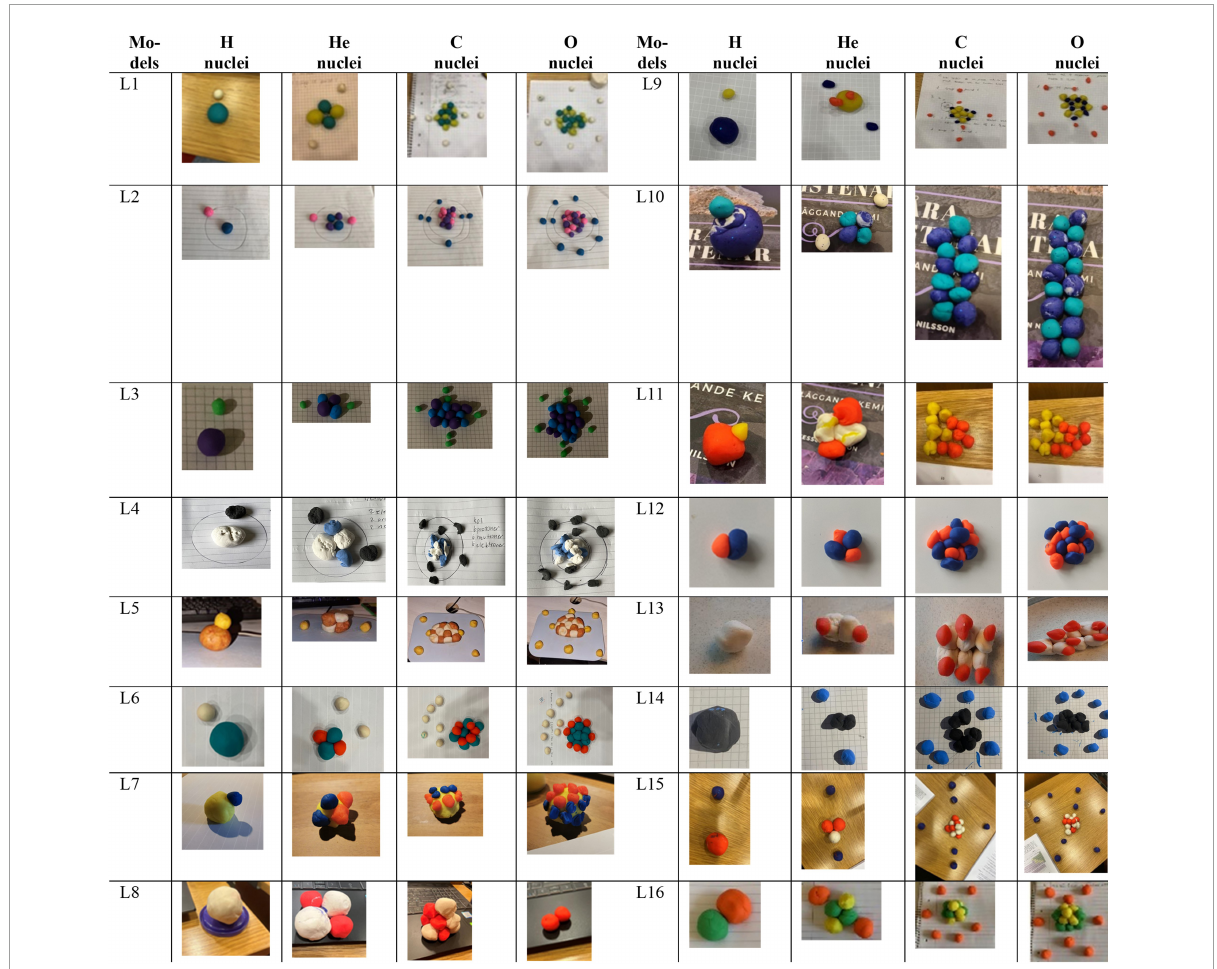
FIGURE3 Models with less resemblance to the teaching model. Series of atomic nuclei in the order: Hydrogen (H), Helium (He), Carbon (C), and Oxygen (O). One student in each row (L1–L16) and the different versions of the nuclei are found in the